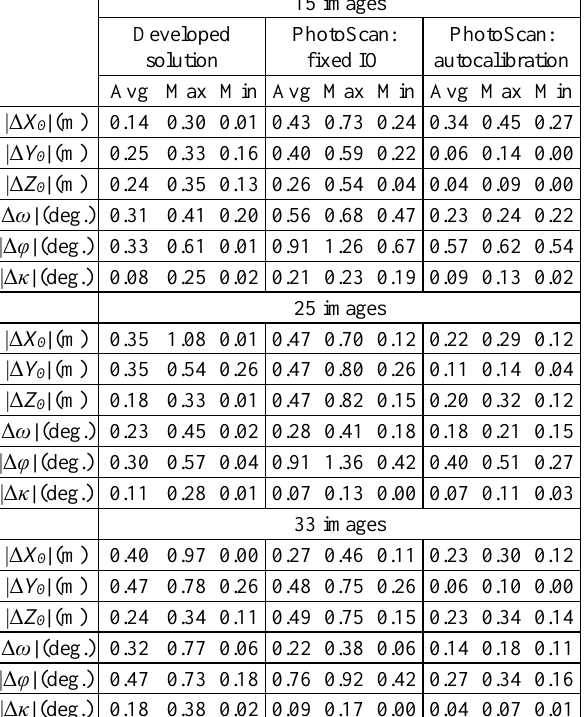
Table 1. Average, maximum and minimum absolute differences between the computed and the reference exterior orientation parameters via various tests; columns 1-3: developed software solution – feature point tracking in images corresponding to a resizing factor of 5, fixed interior orientation (IO); columns 4-6: PhotoScan – feature point tracking in images of original dimensions, fixed IO; columns 7-9: PhotoScan – feature point tracking in images of original dimensions,